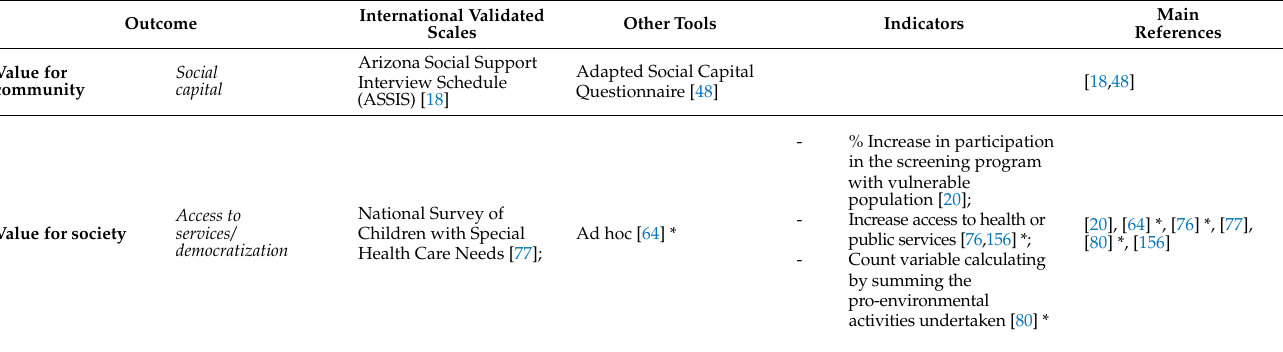
Table 9. Measures and metrics of outcomes for